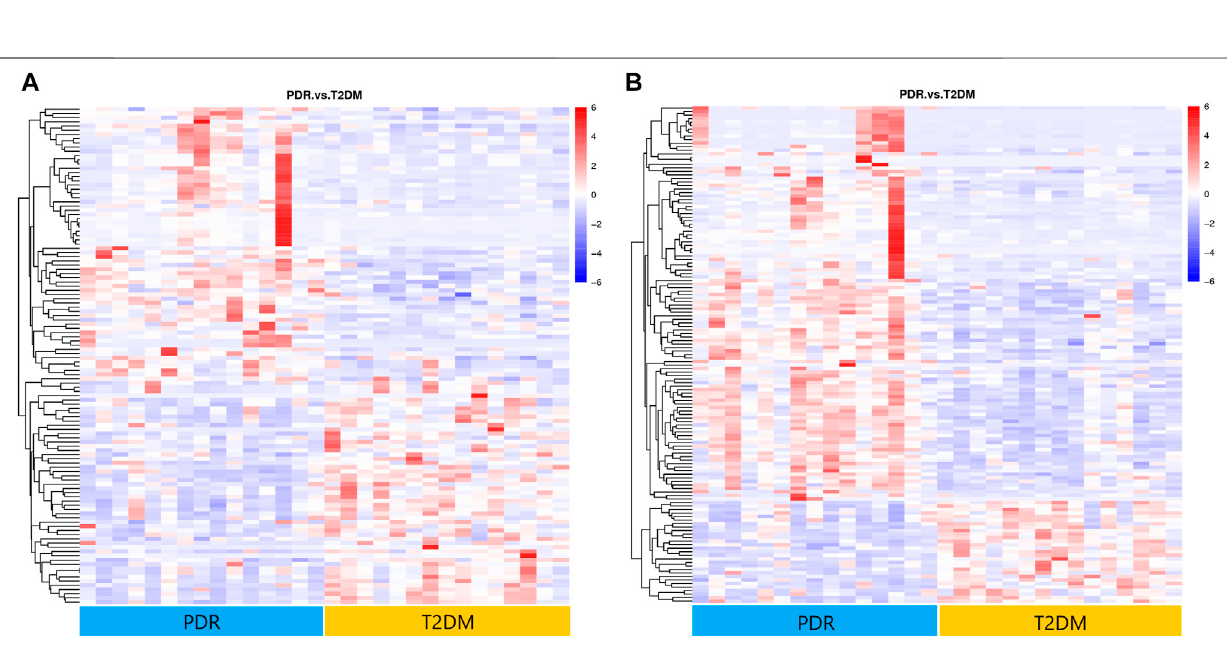
FIGURE 6 | (A) Positive mode. (B) Negative mode. Hierarchical clustering analysis based on the intensity of signi fi cant metabolite features selected by PLS-DA identi fi ed clusters of features that were increased (red) or decreased (blue) in PDR and T2DM patients. There were 141 metabolic features shown in positive mode and 118 metabolic features shown in negative